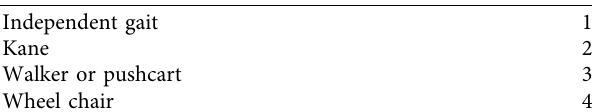
Table 2: Ambulatory state score.